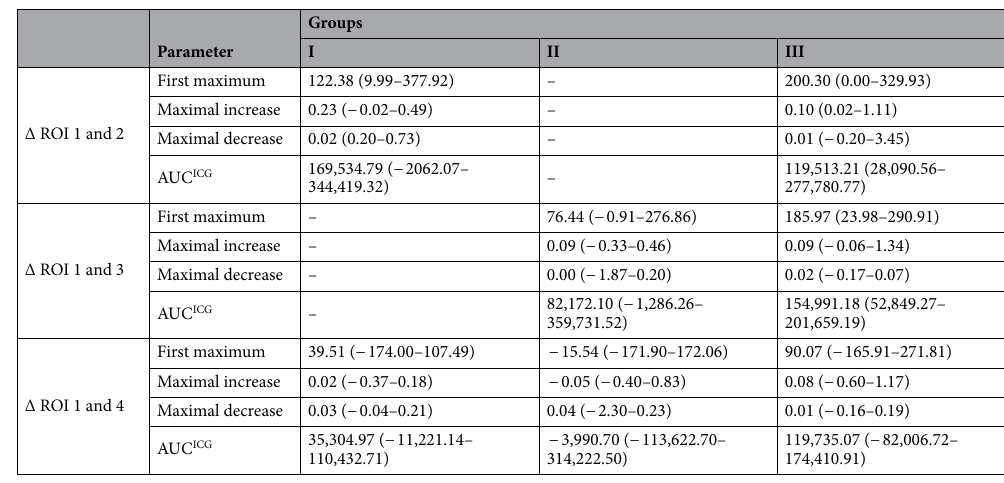
Table 4. Differences of fluorescence behavior (AU) in ICGVA between the defined regions of interest (ROI, 1–4) for the three experimental groups: endothelial defect (ED group I), interposition vein graft (IVG, group II), and ED with IVG (group III). I defect, II interposition vein graft, III defect and interposition vein graft, ROI region of interest, AUC ICG area under the curve. Median (range). Wilcoxon test: significant ( p < 0.05) change in ROI 1 vs. 2, 3, and 4 (*, § , # ) within groups I–III and compared values. Mann–Whitney U test: significant ( p < 0.05) change between groups I vs. II, I vs. III, and II vs. III ( % , & , ? ) for the compared